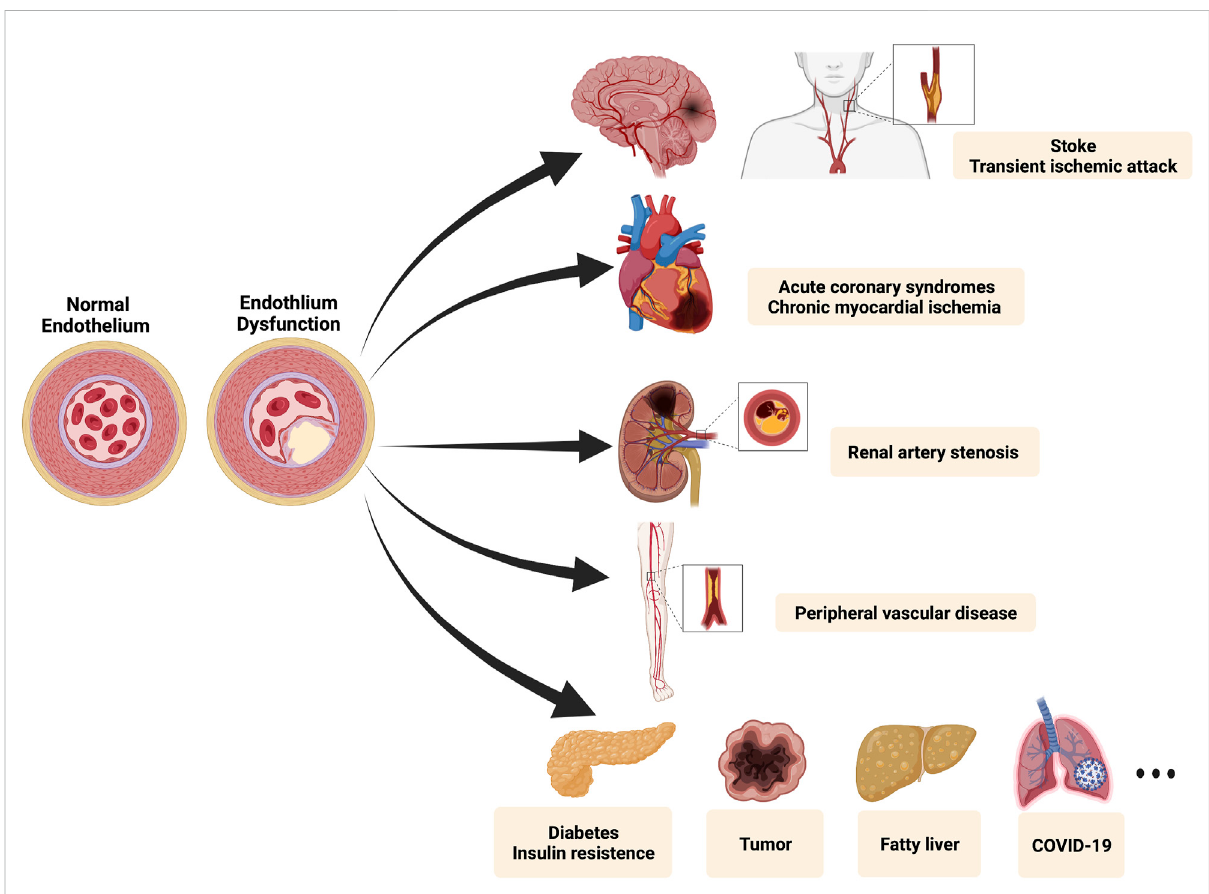
The spectrum of the panvascular system. Endothelial dysfunction is considered as a hallmark of diverse panvascular diseases. Major lesioned vessels involve carotid arteries, cerebral arteries, coronary arteries, renal arteries, and peripheral vessels. Besides relevant clinical manifestations include stroke, transient ischemic attack, acute coronary syndromes (myocardial infarction and unstable angina), chronic myocardial ischemia (stable angina and silent ischemia), renal artery stenosis, peripheral vascular diseases (limb ischemia and intermittent claudication), metabolic syndrome (diabetes and insulin resistance), and many others (tumor, fatty liver, COVID-19, etc. ). Created with